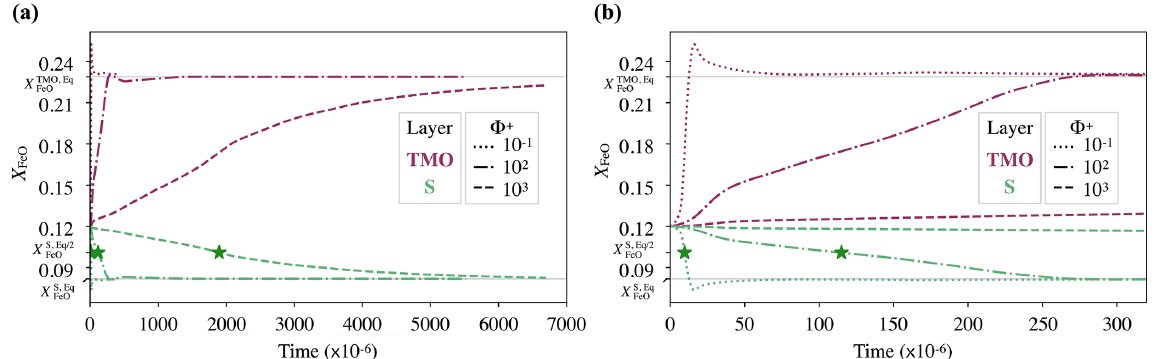
Figure 3. (a) Evolution of the FeO content, X FeO , in the solid mantle (S, green) and top magma ocean of 500km (TMO, pink), with dimensionless time units. We test three different values of phase change number: (cid:56) + = 10 − 1 , 10 2 , and 10 3 (different lines). Green stars correspond to the point where the FeO content in chemical half-equilibrium in the solid mantle, X S, Eq/2